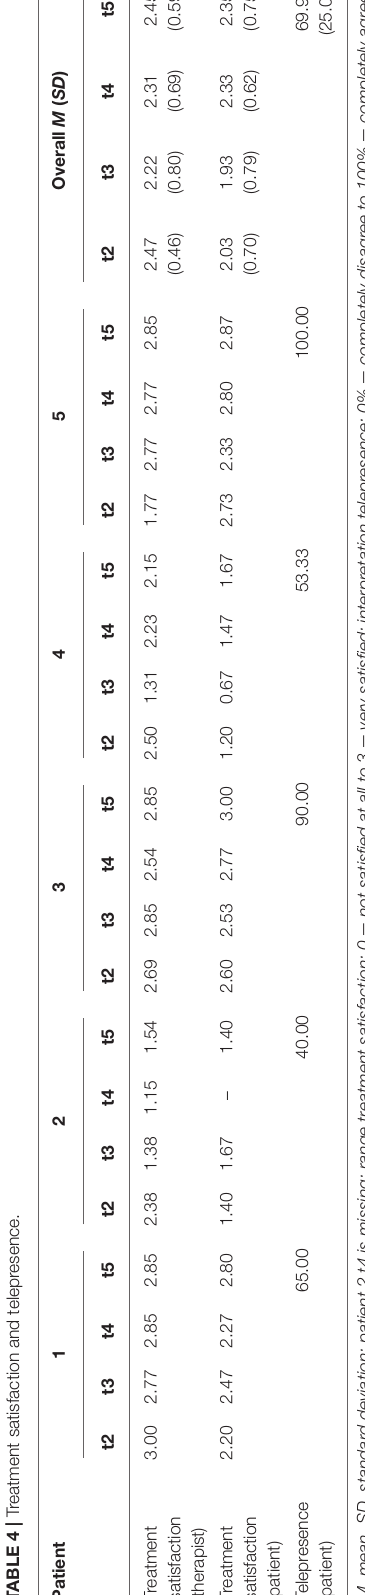
TABLE 3 | Clinical significance: percentage of symptom reduction on YGTSS and percentage of patients with inclusion criterion fulfilled. Patient 1 2 3 4 5 Overall